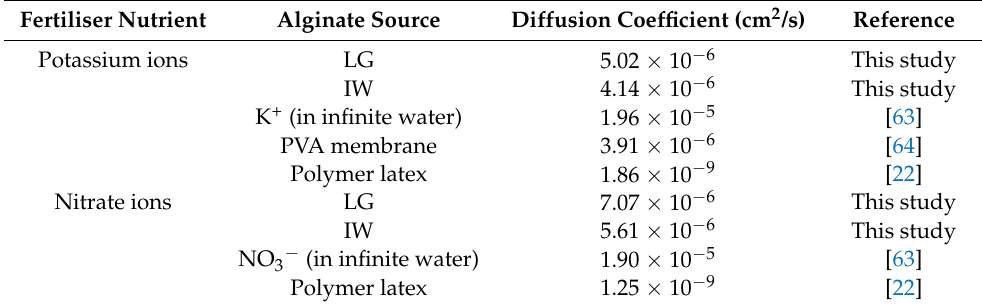
Table 3. Diffusion coefficients determined of K + and NO 3 − from laboratory-grade (LG) alginate- based and industrial waste extracted alginate (IW) slow-release fertilisers into deionised water at 25 ◦ C. Diffusion coefficients determined by previous research is also shown for